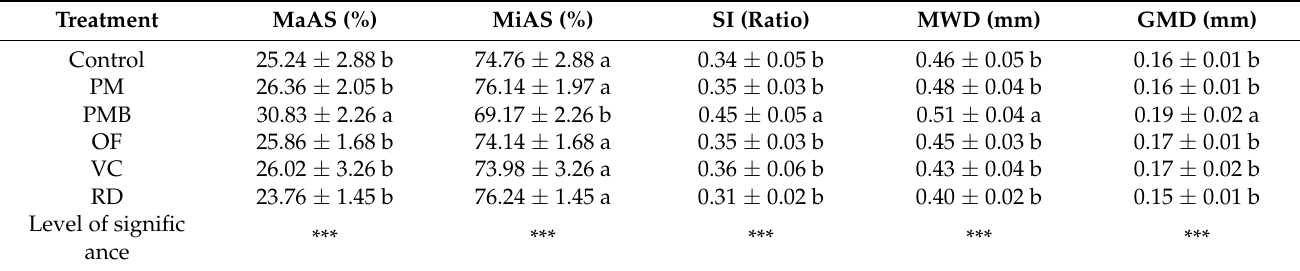
Table 7. Effects of different treatments on soil aggregate properties of charland